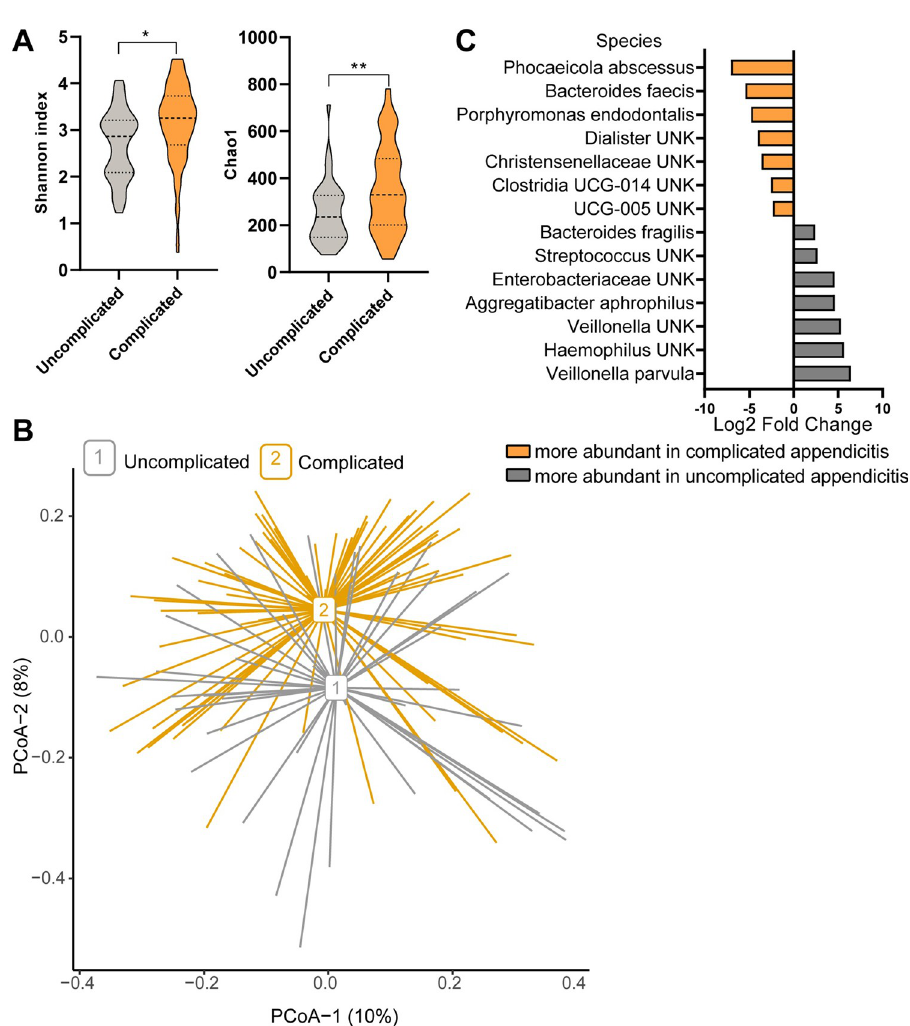
Fig 2. The difference in appendiceal microbiota between uncomplicated and complicated acute appendicitis. A) Violin plot representing alpha diversity measures Shannon index and Chao1 in uncomplicated and complicated acute appendicitis. � p < 0.05 and �� p < 0.01). B) Principal Coordinates Analysis (PCoA), i.e. beta diversity, based on Bray- Curtis distances. The percentage of variation explained by the two first PCoA dimensions is indicated on the respective axes. C) Barplot showing significantly (adj p < 0.01) differentiating species in uncomplicated compared to complicated that were present in meaningful levels (average relative abundance > 0.1%). Species are listed along the y-axis and x- axis indicates the log2 fold change. UNK = unknown